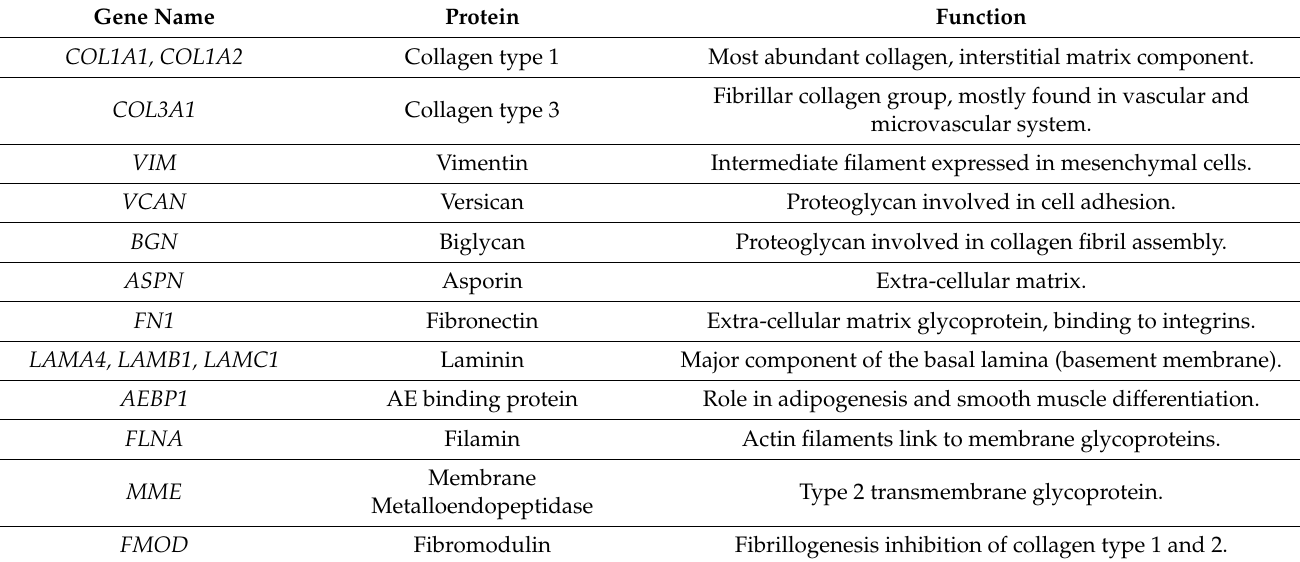
Table 4. Connective tissue genes and